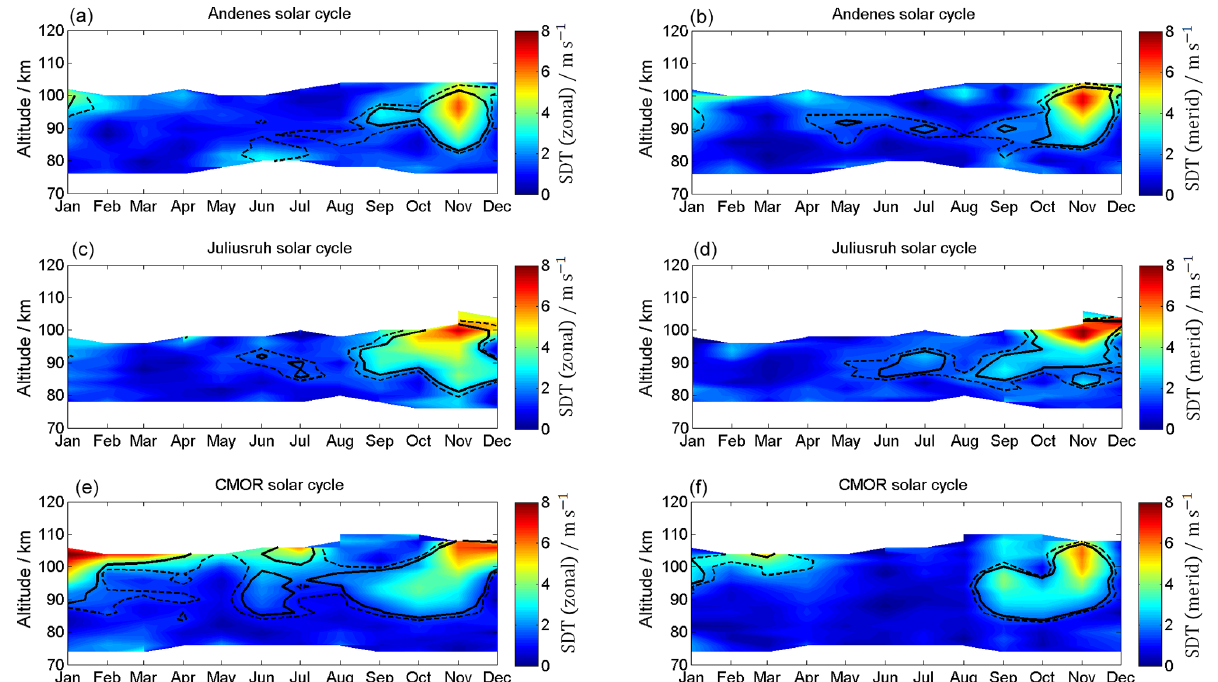
very long data sets used in our study show that there is a sig- nificant year-to-year